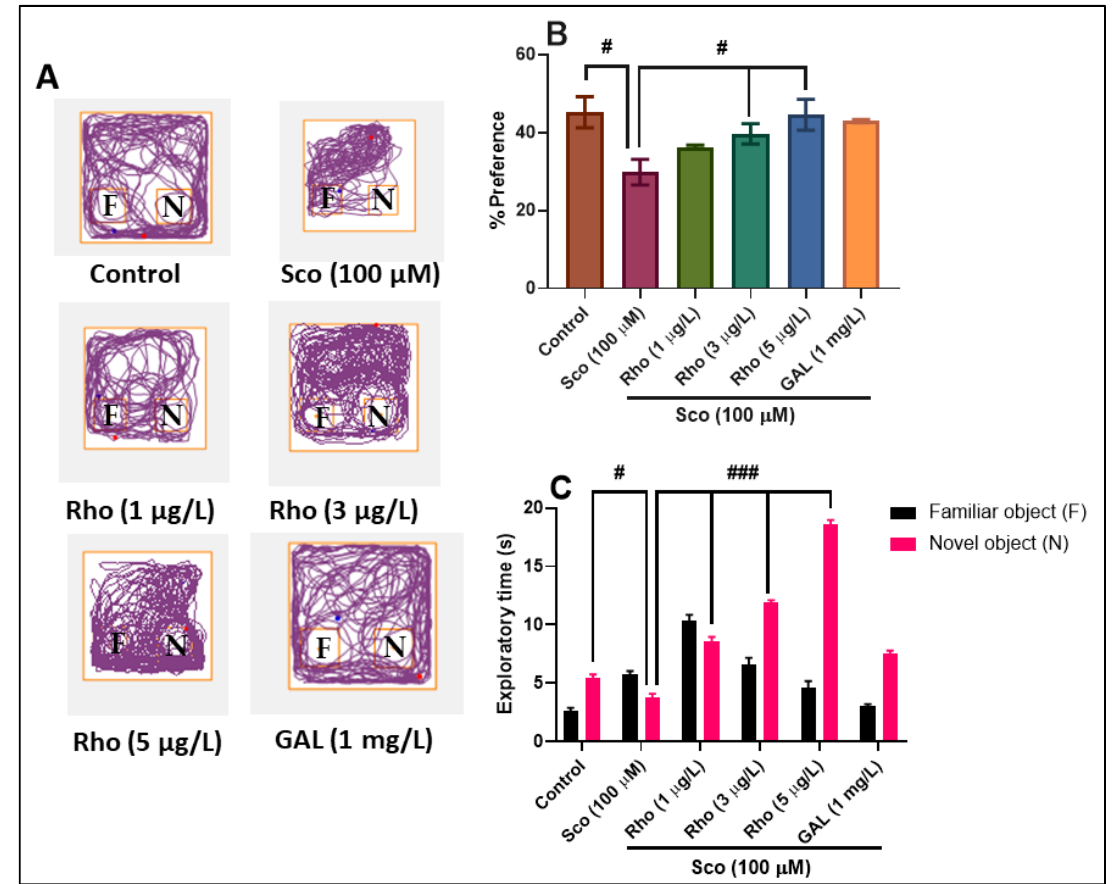
Figure 4. Rhoifolin (Rho: 1, 3, and 5 μ g/L) improved memory in the novel object recognition test (NOR). ( A ) Representative locomotion tracking pattern of the control, scopolamine (Sco: 100 μ M), rhoifolin (Rho: 1, 3, and 5 μ g/L), and galantamine (GAL: 1 mg/L) treated groups. ( B ) Representation of the percentages of preference in different groups. ( C ) Representation of the exploratory time in different groups. Values are means ± S.E.M. (n = 10). For Tukey’s post hoc analyses: ( B ) Control vs. Sco (100 μ M): # p < 0.01, Sco vs. Rho (3 μ g/L): # p < 0.01, and Sco vs. Rho (5 μ g/L): # p < 0.01; ( C ) Control vs. Sco (100 μ M): # p < 0.01, Sco vs. Rho (1 μ g/L): ### p < 0.0001, Sco vs. Rho (3 μ g/L): ### p < 0.0001, and Sco vs. Rho (5 μ g/L): ### p < 0.0001.